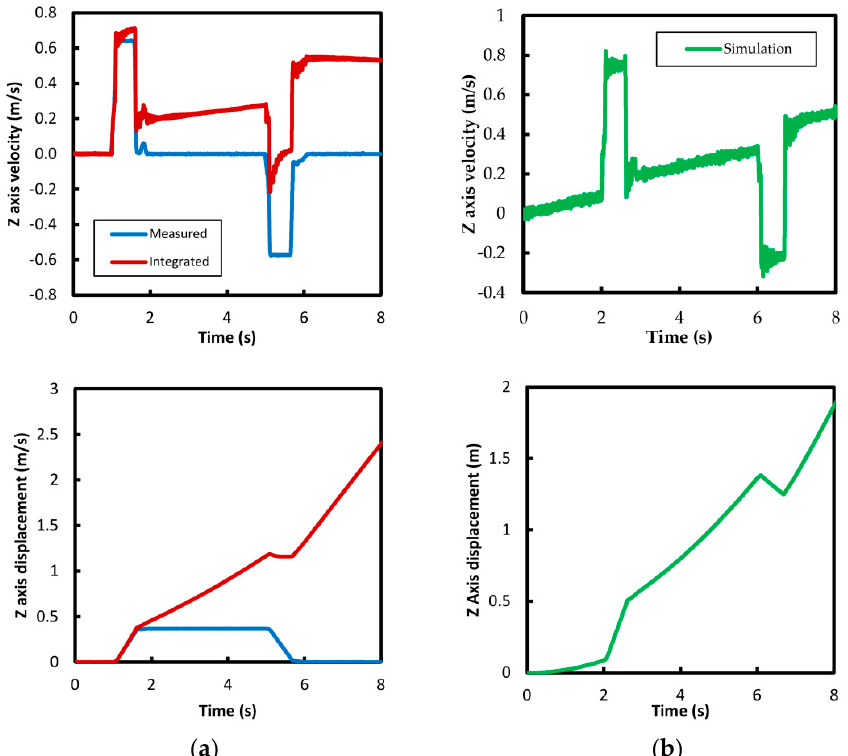
Figure 18. Experimental and calculated results of velocity and displacement in Z axis; ( a ) experimental results; ( b ) simulation results.